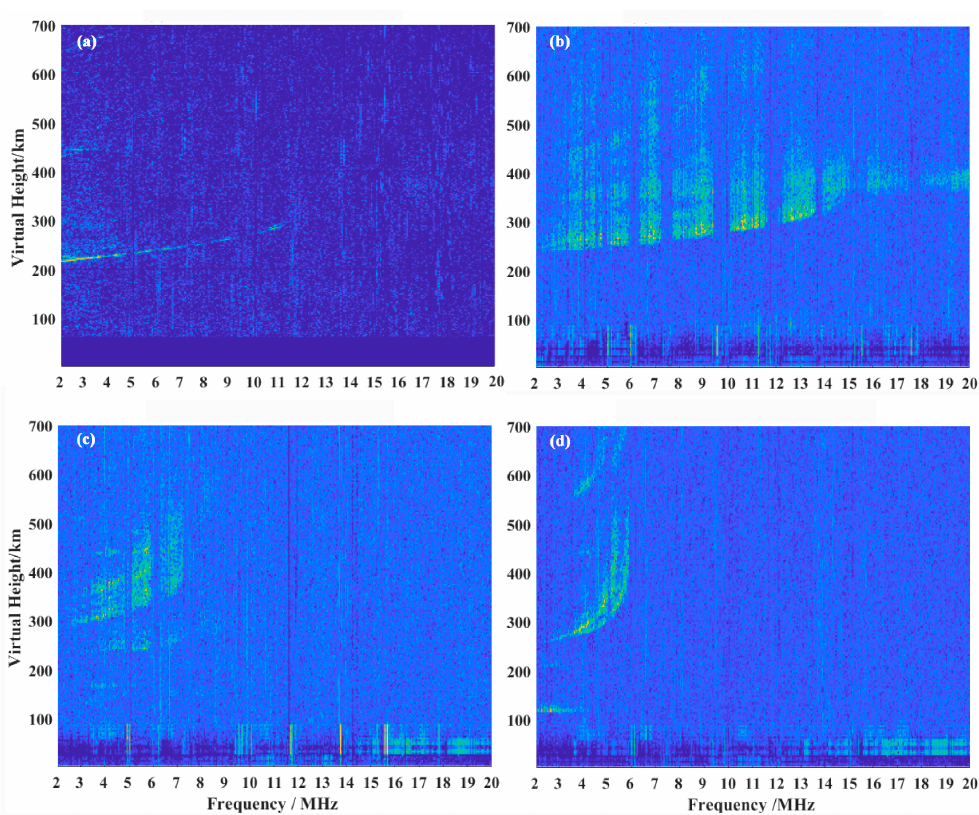
Figure 2. A typical example of different types of SF. ( a ) RSF recorded at CMU station, ( b ) SSF recorded at PUR station, ( c ) MSF recorded at LS station and ( d ) FSF recorded at LS station.